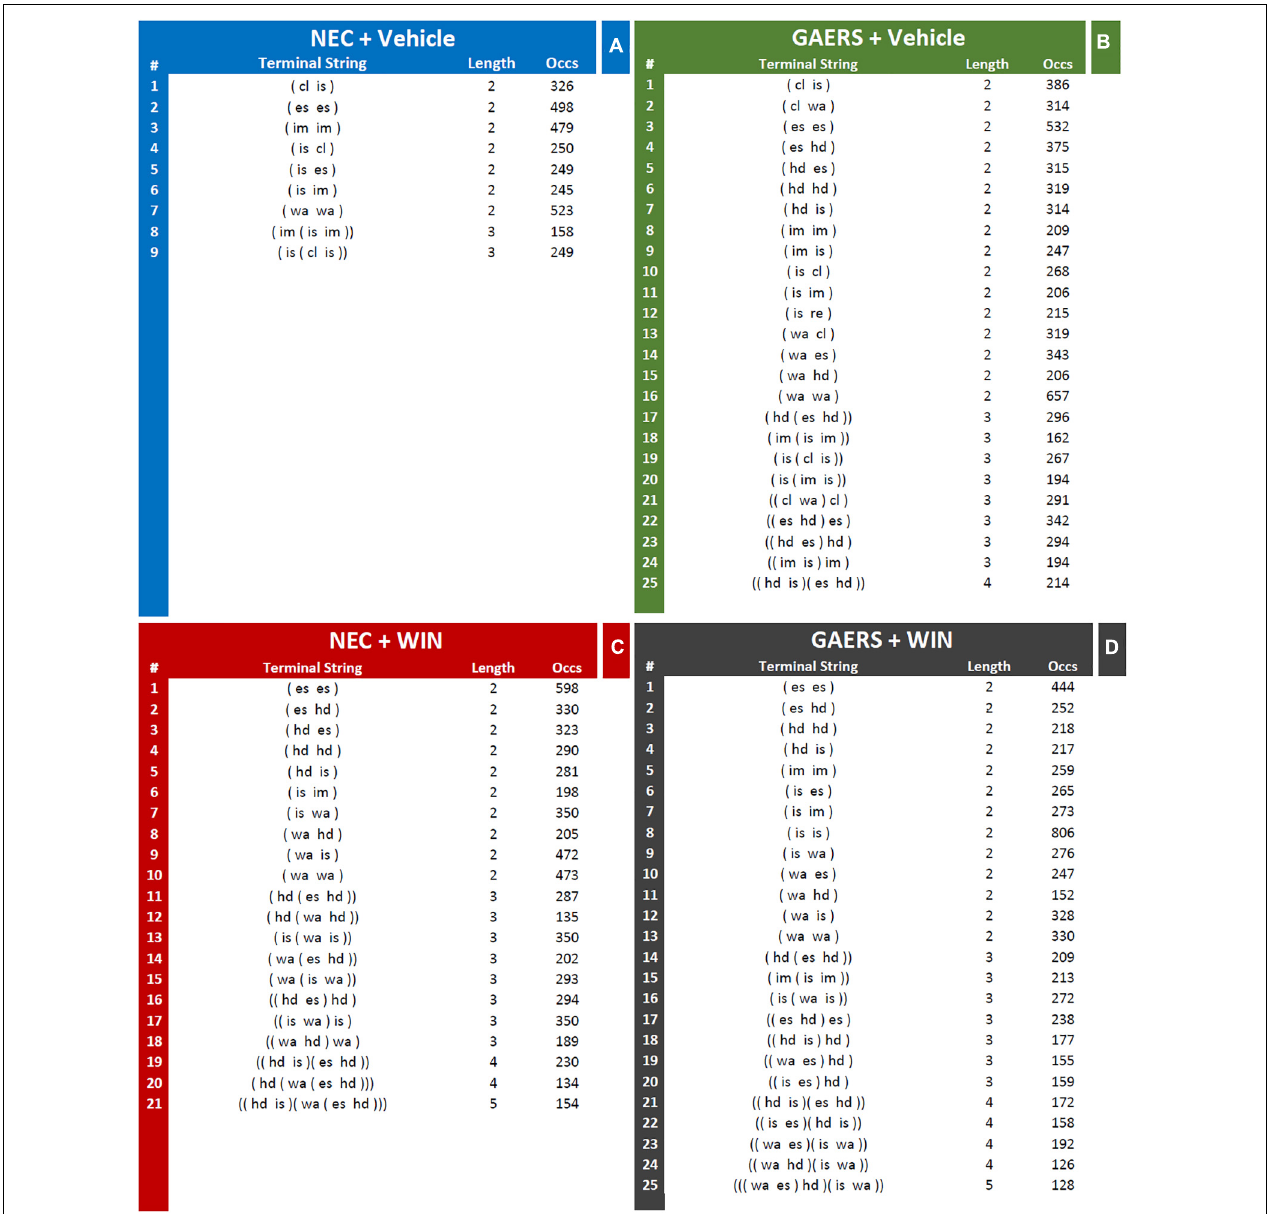
FIGURE 5 | Effect of WIN 55,212-2 and its vehicle on the number of T-patterns of different lengths in GAERS and NEC rats. Administration of WIN 55,212-2 (WIN; 2 mg/kg, IP) and its vehicle affected the overall number of different T-patterns detected based on their length for each group during the 10 min of the hole-board test. Filled bars = number of patterns detected in the real data; white bars = average number + 1xSD of patterns detected in randomized